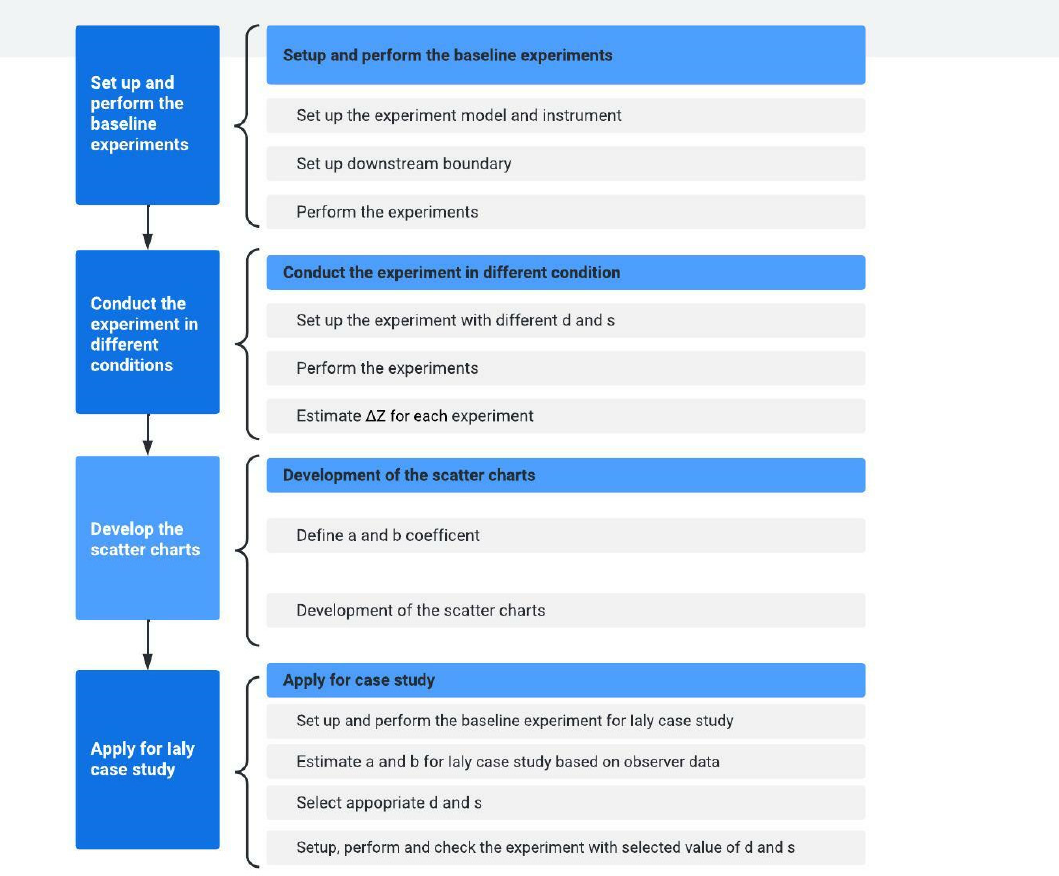
Figure 1. The methodology flow chart.